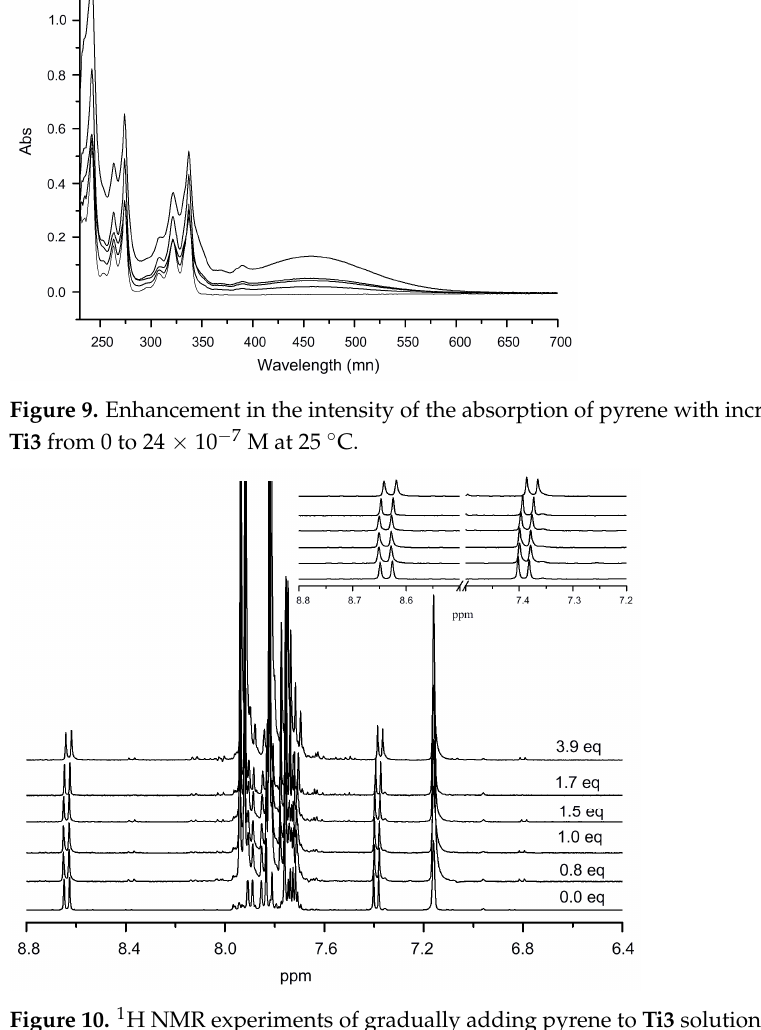
Ti3 . Figure S1: 13 C NMR spectrum of ethylene/1-hexene copolymer obtained with Ti1 /MAO system (Table 2, Entry 9); Figure S2: 13 C NMR spectrum of ethylene/1-hexene copolymer obtained with